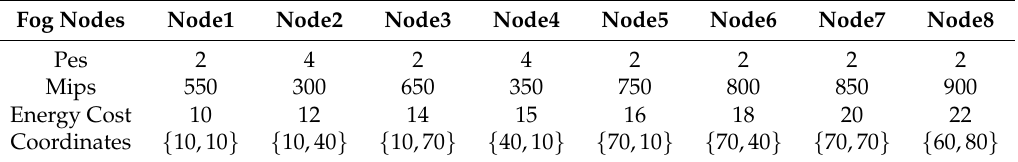
Table 2. Performance configuration and computing power parameters (adapted from CloudSim). Fog Nodes Node1 Node2 Node3